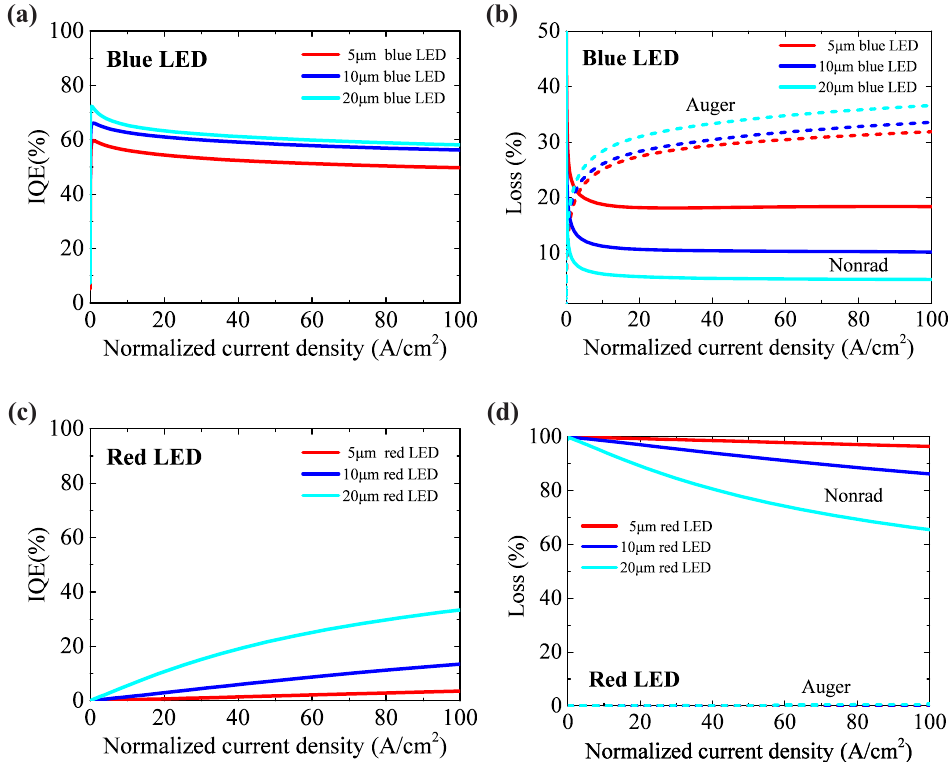
Figure 3. IQE of ( a ) blue and ( b ) red µ -LEDs with three different chip sizes that may be affected by SRH and Auger recombination, ( c ) for blue and ( d ) for red µ